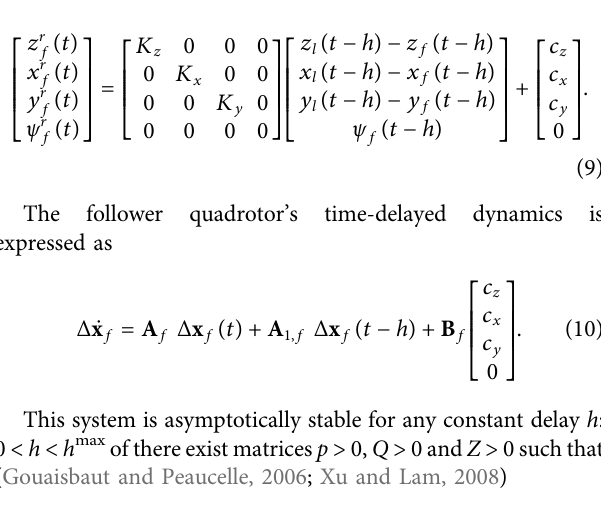
FIGURE 6 | Developed UAV-rendering (A) and physical prototype (B)